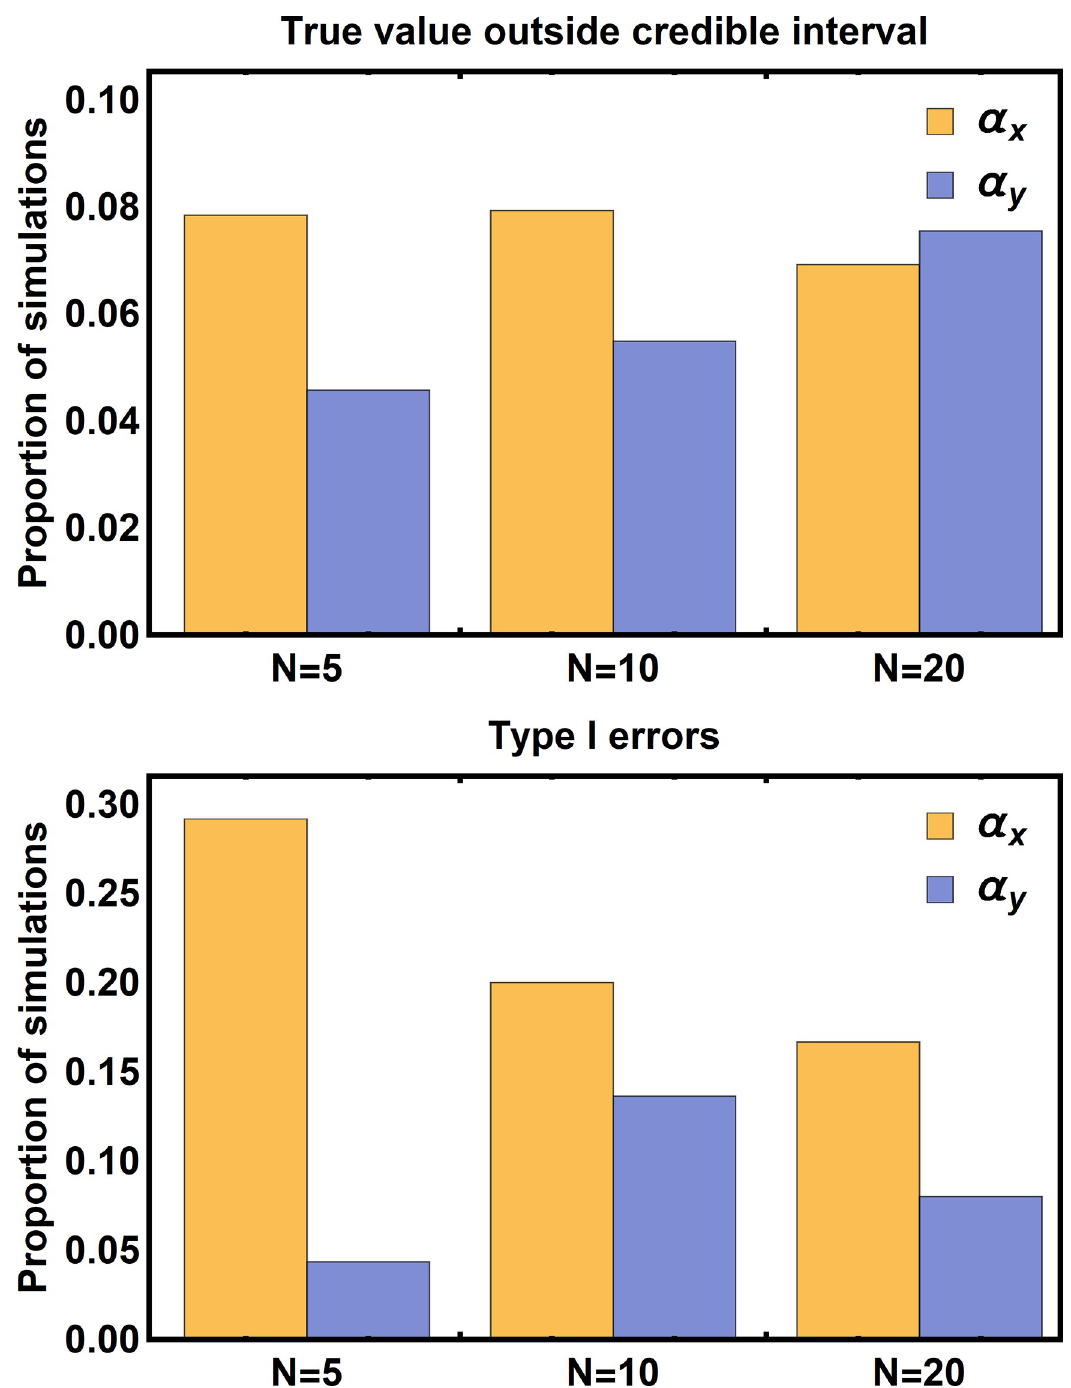
Fig 2. The proportion of simulations where the true value of the parameter fell outside of the 95% credible interval of its posterior distribution (top panel) and the proportion of simulations where the true value of the parameter was equal to zero, but the credible interval did not include zero (bottom panel). Inference was performed using very broad priors restricted only by biological feasibility.